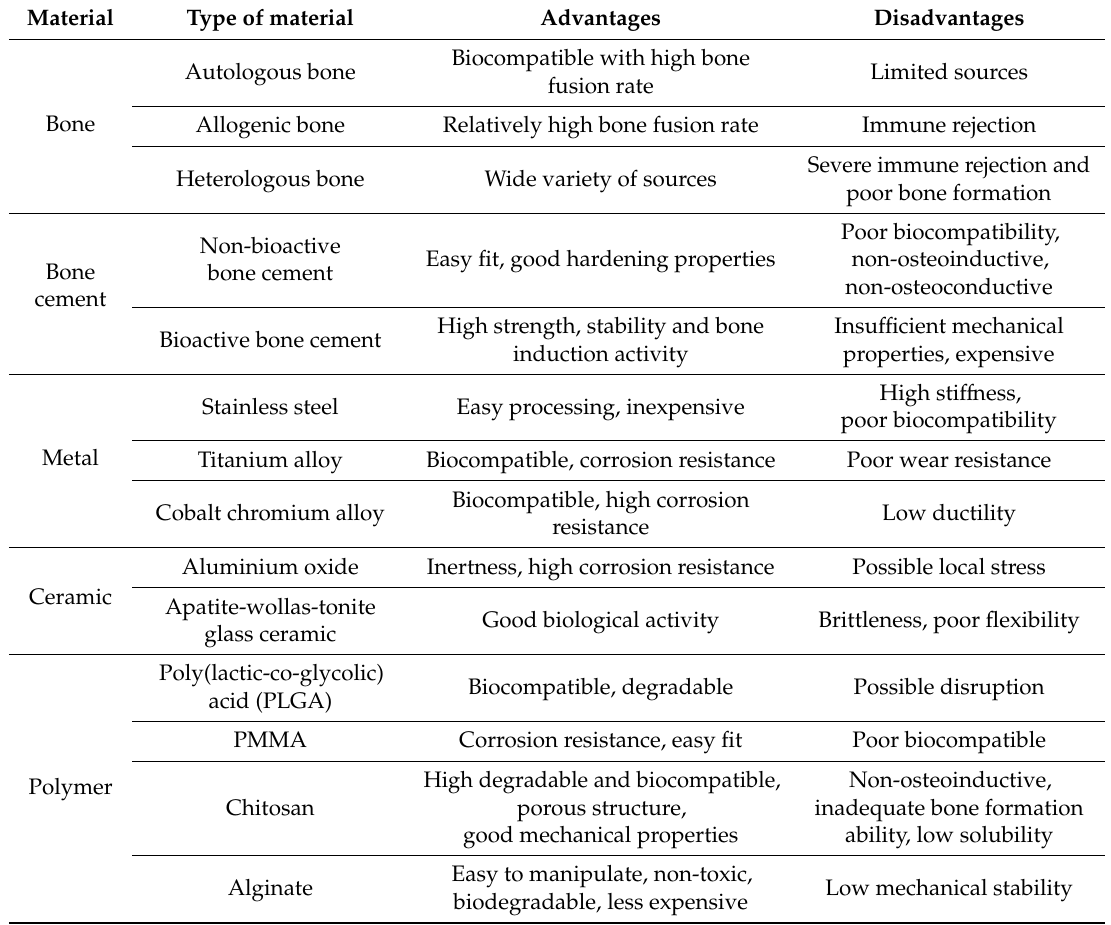
Table 8. Traditional materials used for bone repair